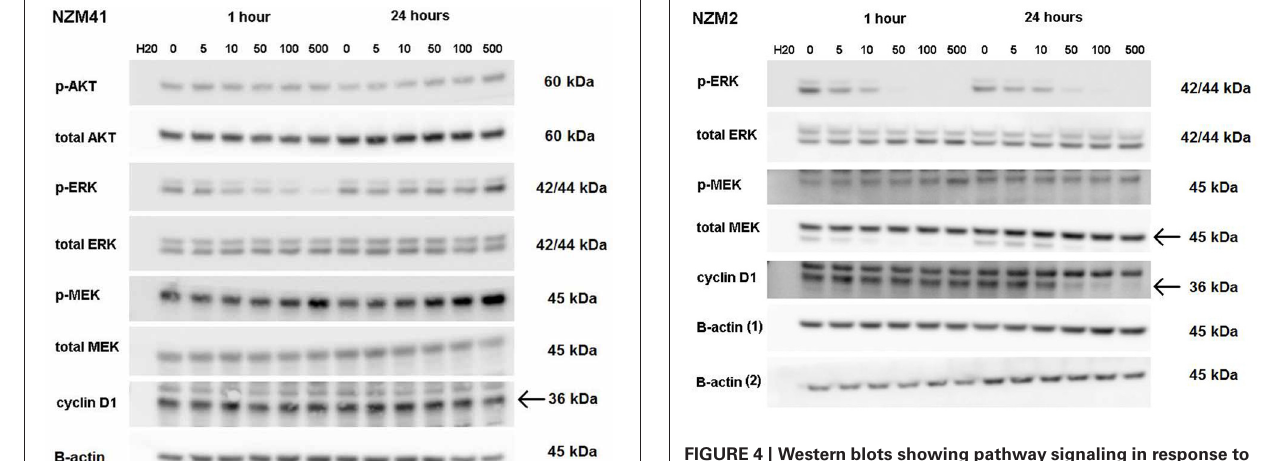
FIGURE 4 | Western blots showing pathway signaling in response to CI-1040 (nanomolar concentrations) for the NZM2 line (BRAF wildtype) at 1 and 24h. The arrows indicate the protein of interest in blots where non-specific bands are also